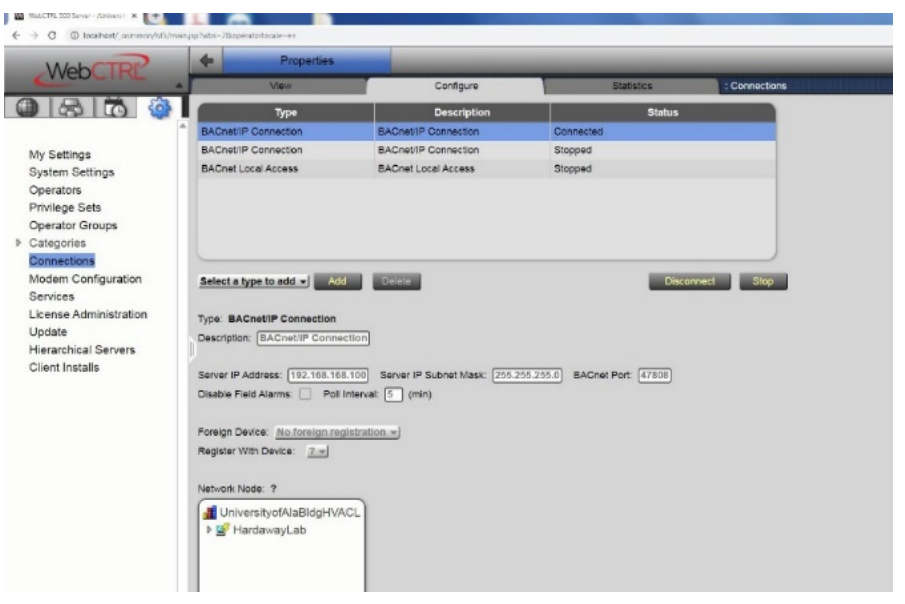
Figure 14. Communication configurations in WebCTRL through UDP.